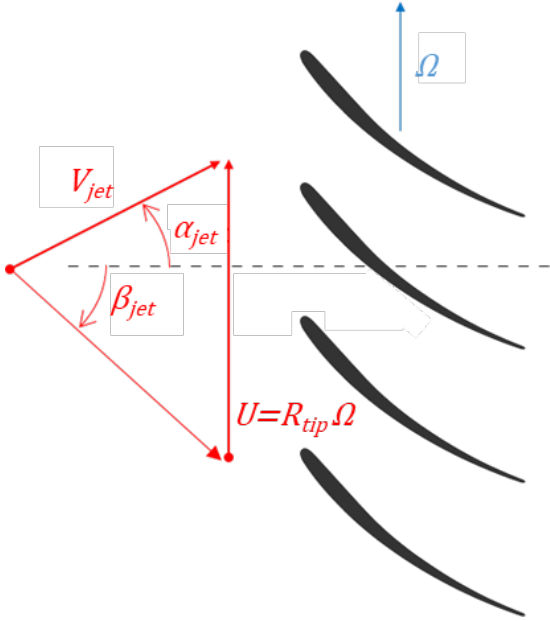
Figure 5. Definition and illustration of the absolute and relative blowing flow angles. Positive angle values are given by the rotor rotation direction.